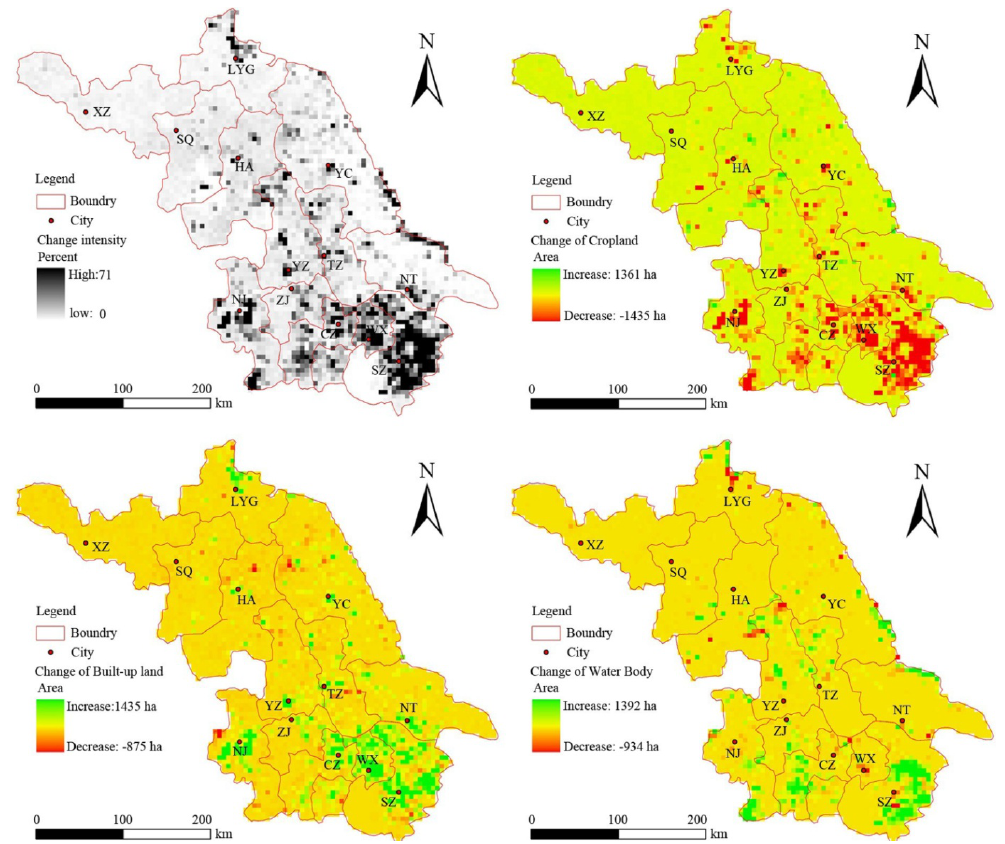
Figure 4. Spatial distribution of land use change from 2000 to